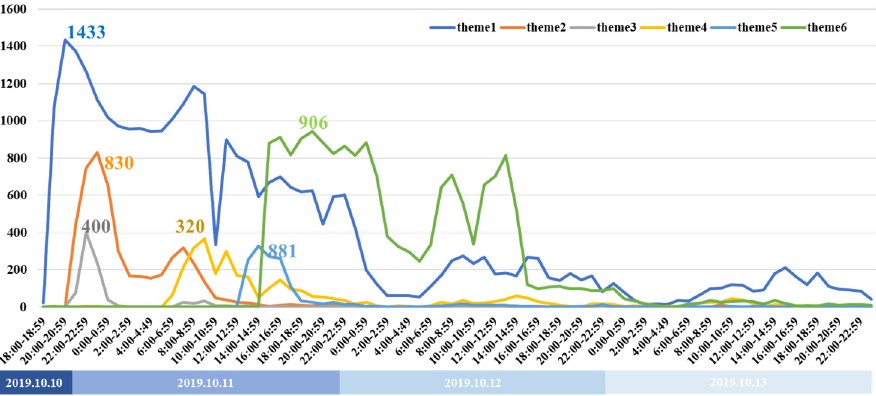
Figure 7. Number of messages related to the accident on different themes.